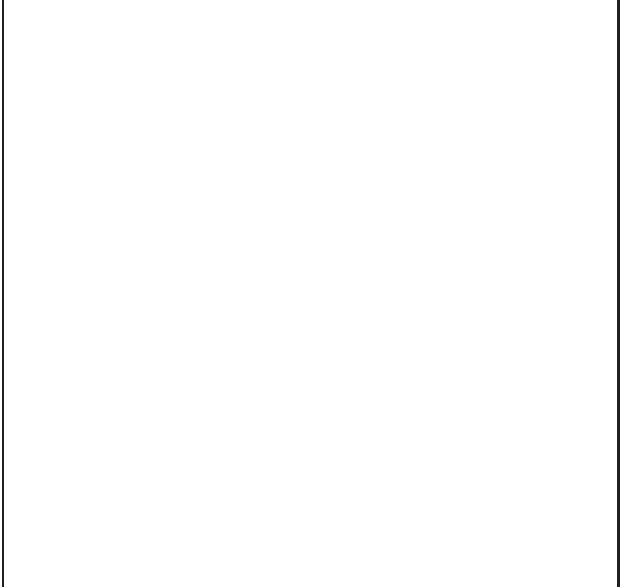
Fig. 4 : Records of patients.